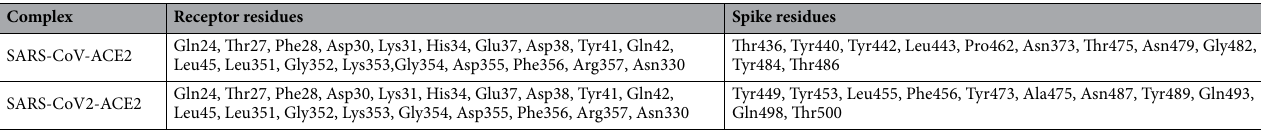
Table 3. The native contact interaction list for SARS-CoV-ACE2 and SARS-CoV-2-ACE2.